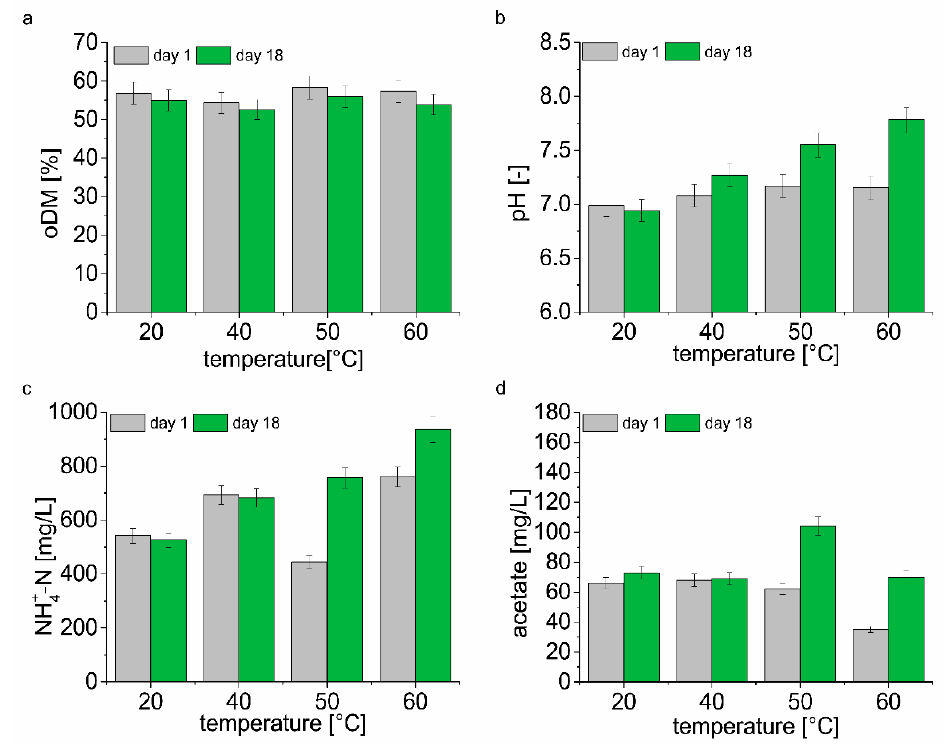
Figure 2. Digestate parameters at day 1 and day 18; organic dry matter content ( a ); pH ( b ); NH 4 + -N concentration ( c ); and acetate concentration ( d ); error bars represents ± SD, n = 3.